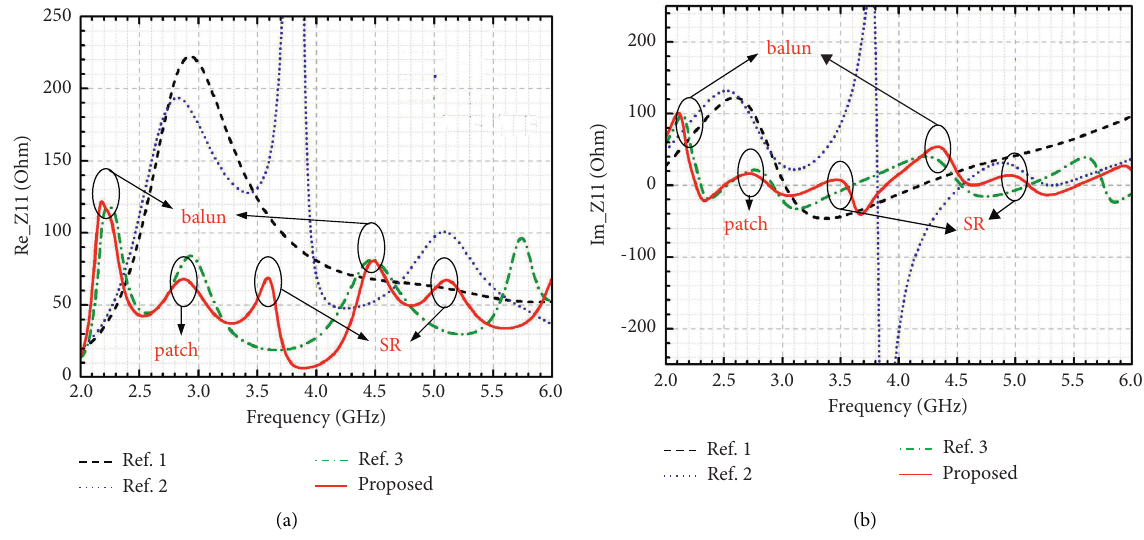
Figure 3: Input impedance of the evolution of the proposed antenna. (a) Real part and (b) imaginary part.